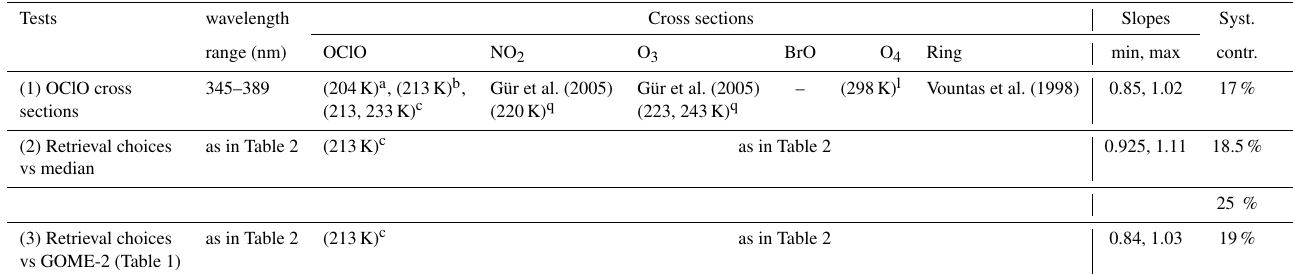
Table A2. Description of the different sensitivity tests performed and a summary of the main results. The letters refer to the footnotes of Table 2. Cross sections Slopes